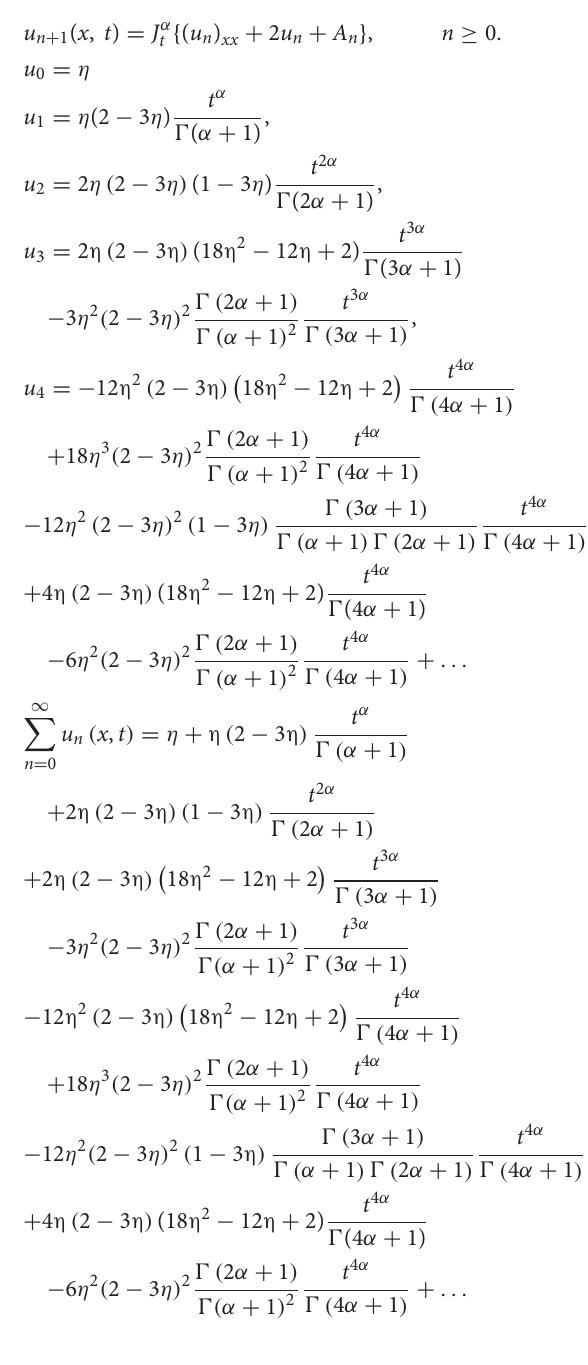
FIGURE 2 | Surface represents exact solution for α